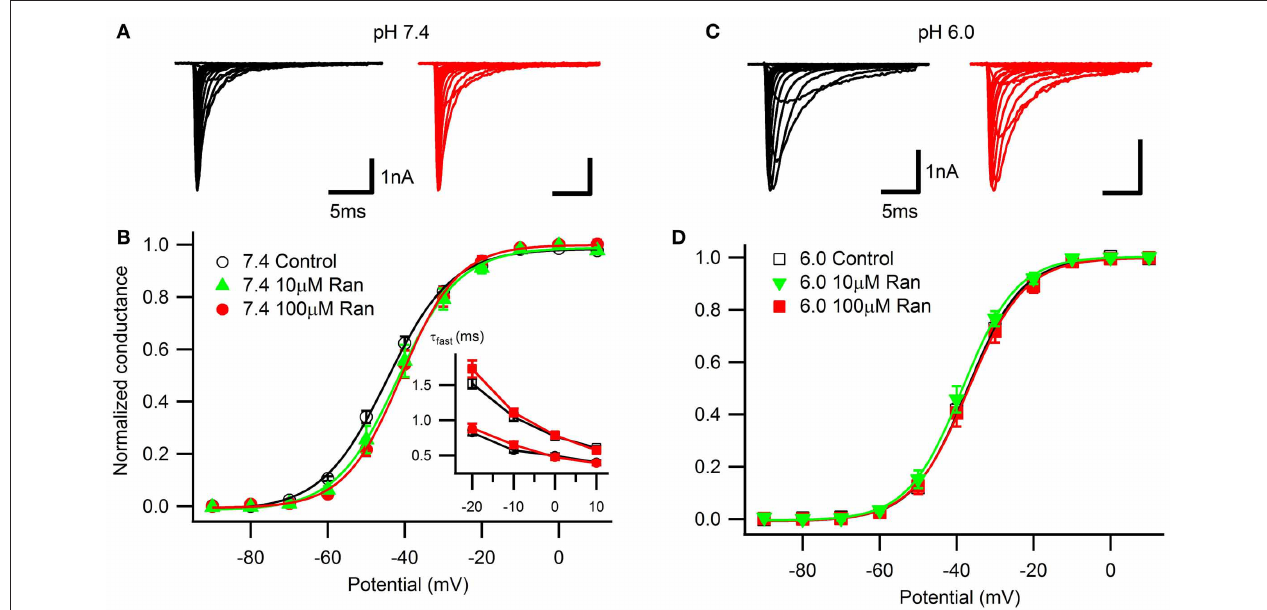
FIGURE 1 | Voltage-dependence of activation and open-state inactivation time constants. Representative currents in response to 20ms depolarizations in 10mV steps from − 130mV at extracellular pH 7.4 (A) and 6.0 (C) in drug-free conditions (black) and with 100 μ M ranolazine (red). (B) Conductance-voltage relationships at pH 7.4 in control (open black circles), 10 μ M ranolazine (solid green triangles), and 100 μ M ranolazine (solid red circles). (D) Conductance-voltage relationships at pH